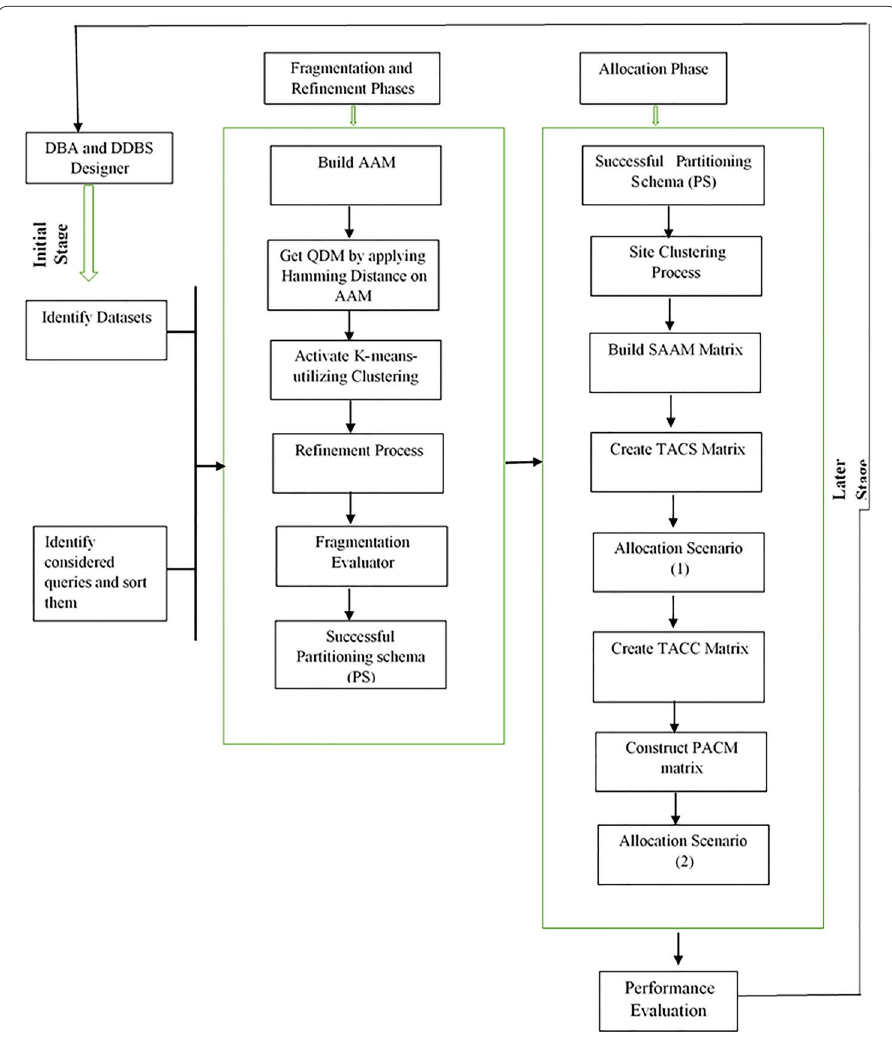
Fig. 1 Approach architecture diagram: briefly and enthusiastically display approach